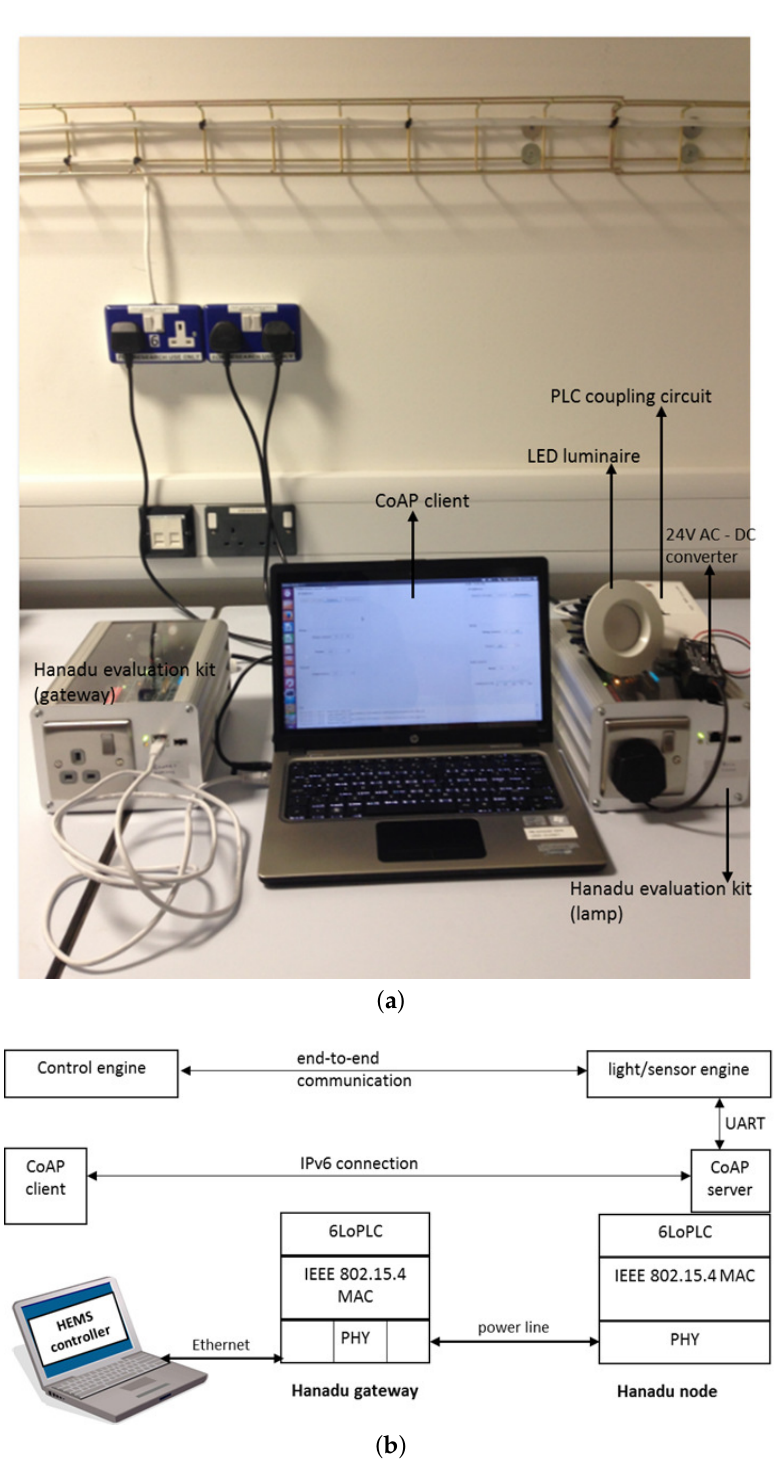
Figure 1. Hanadu low-power PLC system over the IPv6 network (6LoPLC) test bench showing ( a ) the main functional components and ( b ) the communication among system